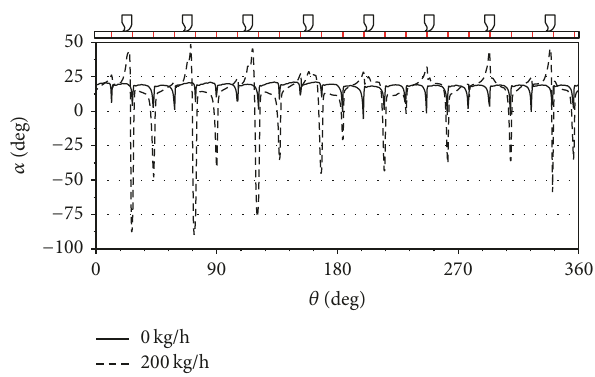
Figure 18: Absolute velocity flow angle at 0.9 span at the diffuser inlet.